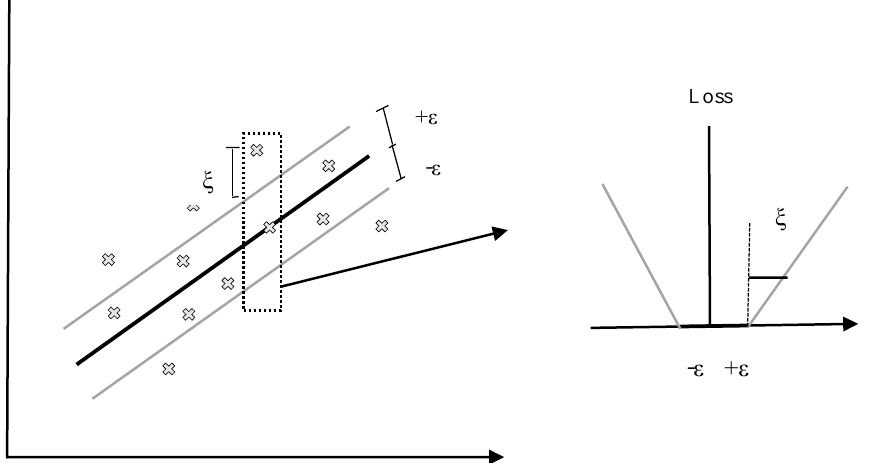
Figure 5. SV regression with an intensive loss function ( ε ) and slack variable ( ξ ) (Obtained from Samui and Dixon [65]).